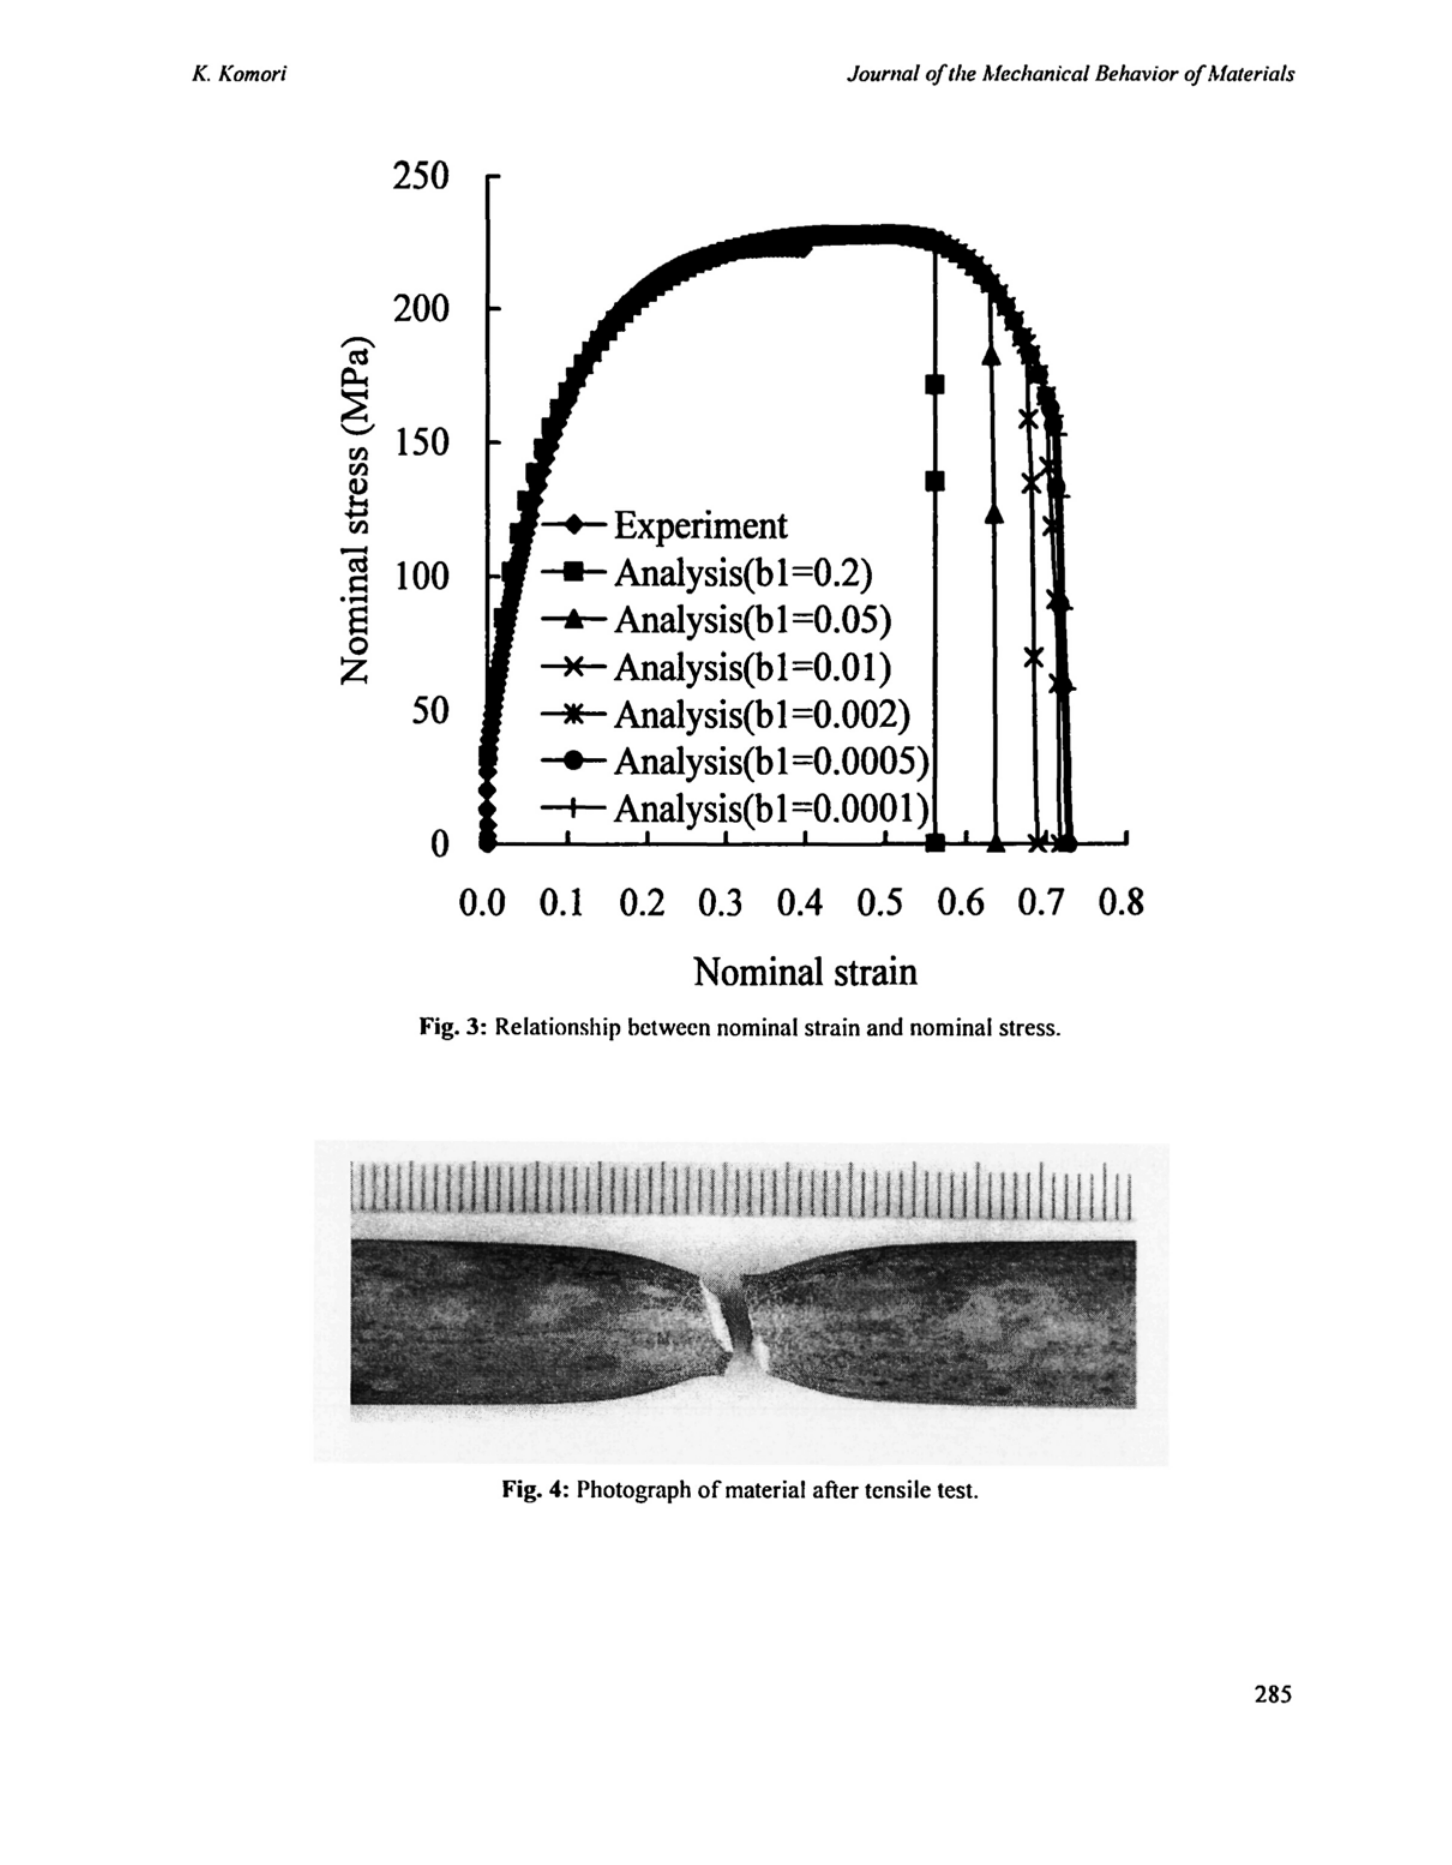
Fig. 4: Photograph of material after tensile